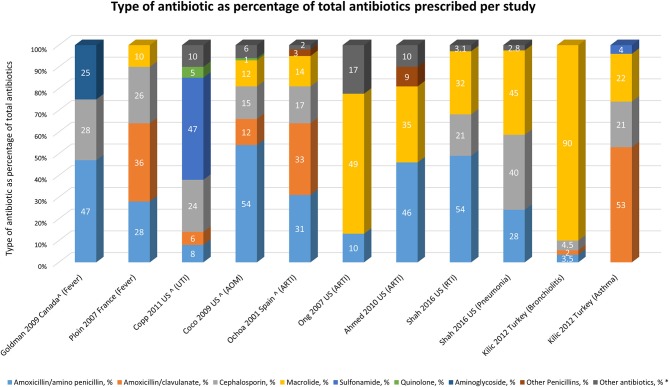
Type of antibiotic as percentage of total antibiotics prescribed per study. *As defined in article. Ahmed et al. (19): not specified; Copp et al. (32): nitrofurantoin and others are not specified antibiotics. Coco et al. (30): not specified. Ochoa et al. (56): trimethoprim/sulfamethoxazole, clindamycin, fosfomycin, rifampin, trimethoprim, topical use and others are not specified. Ong et al. (57): trimethoprim/sulfamethoxazole; Shah et al. (63): not specified. ∧Calculated from article as percentage of total antibiotics, in article given as percentage of cases.